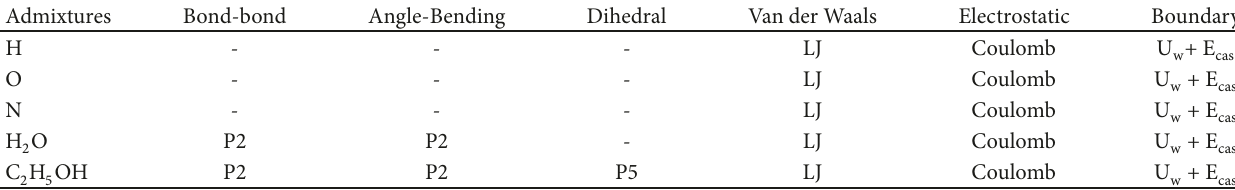
Table 1: Force field